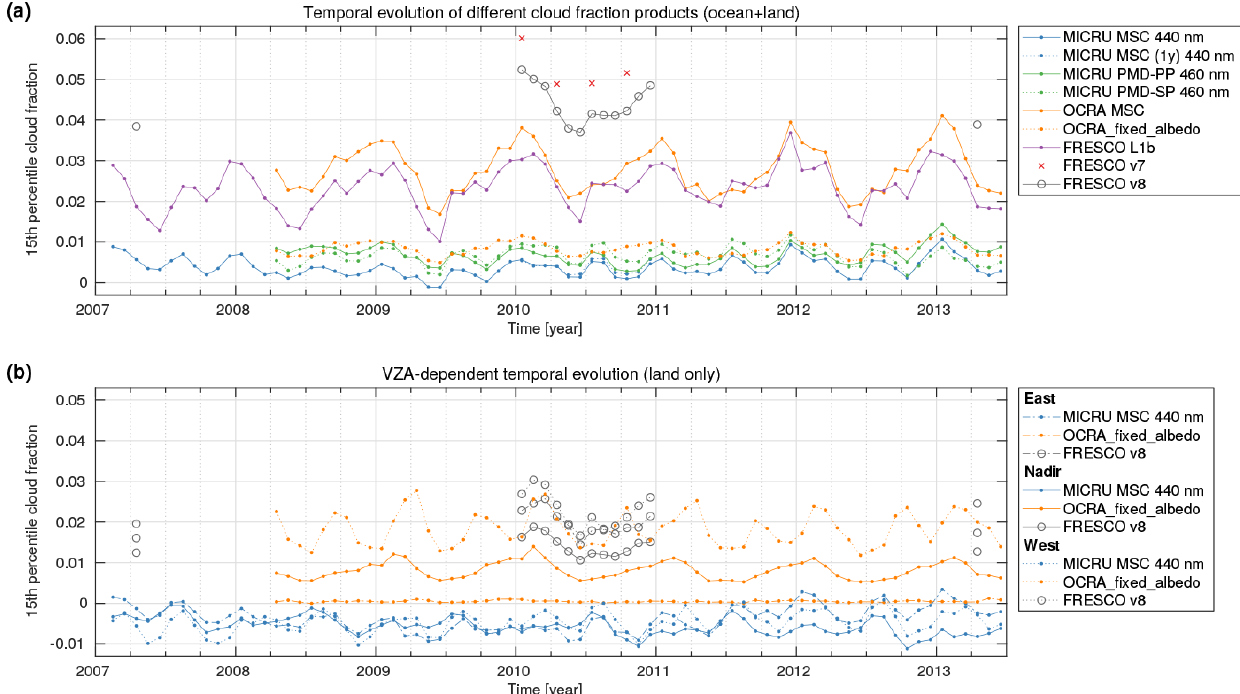
Figure 24. Temporal evolution of the 15th percentile of monthly cloud fraction distributions: (a) comparison between selected MICRU channels, two OCRA versions, and three FRESCO versions, and (b) viewing angle dependency of MICRU, OCRA_fixed_albedo, and FRESCO v8. Note that the offset between the blue line in panel (a) and the average of the blue lines in panel (b) is due to a different data subset that is all vs. land only, respectively. FRESCO L1b and v7 results are omitted in panel (b) for the sake of